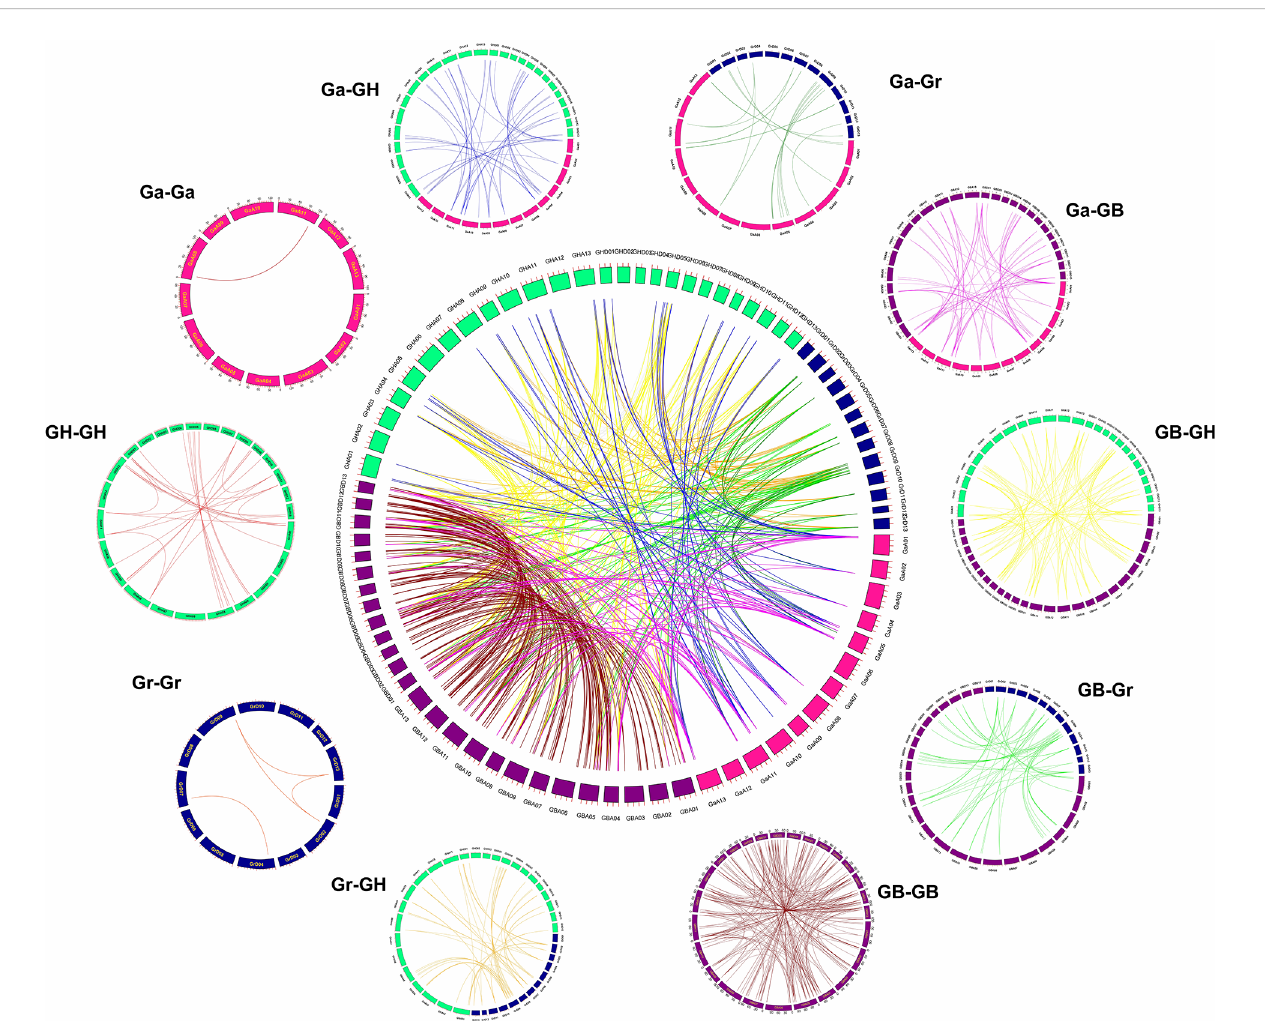
FIGURE 4 Syntenic relationship of 699 duplicated genes pairs in cotton. GHA, GHD, GBA, GBD, GaA and GrD represent At/Dt sub-genome of G. hirsutum , At/Dt sub-genome of G. barbadense , A genome of G. arboreum and D subgenome of G. raimondii ,